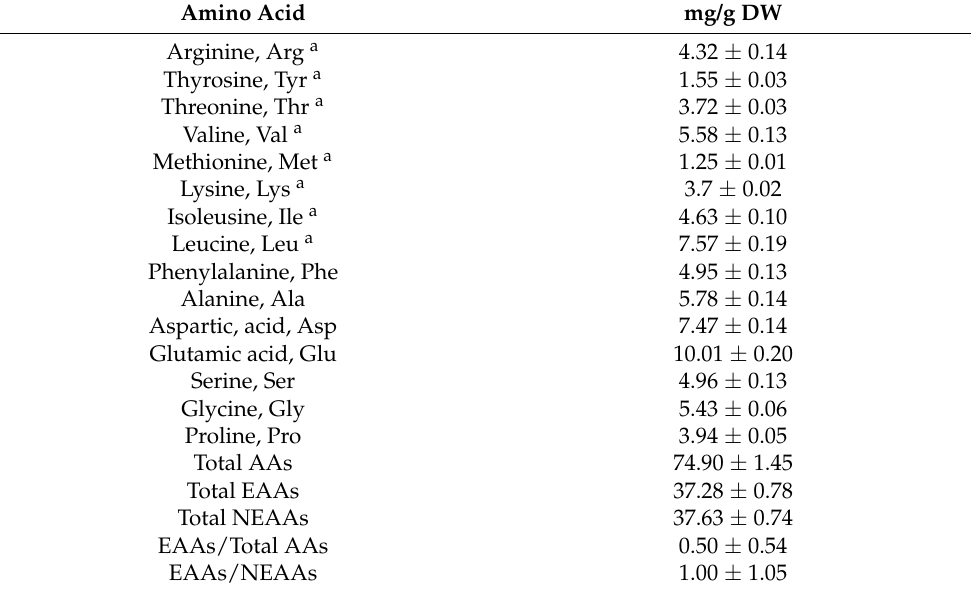
Table 6. Amino acid content of S. polycystum